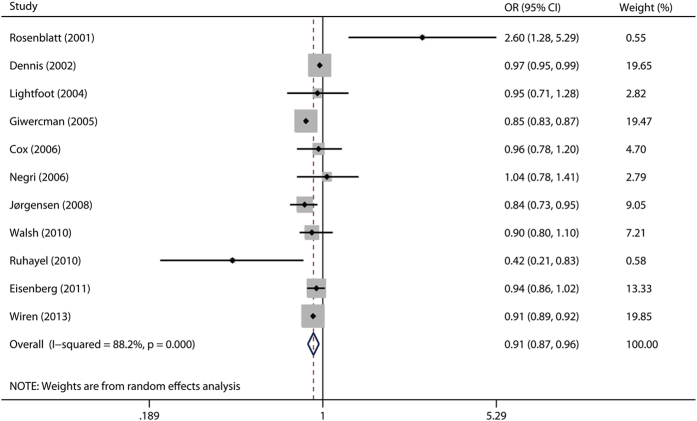
A forest plot showing risk estimates from case–control and cohort studies estimating the association between fatherhood status and prostate cancer risk.